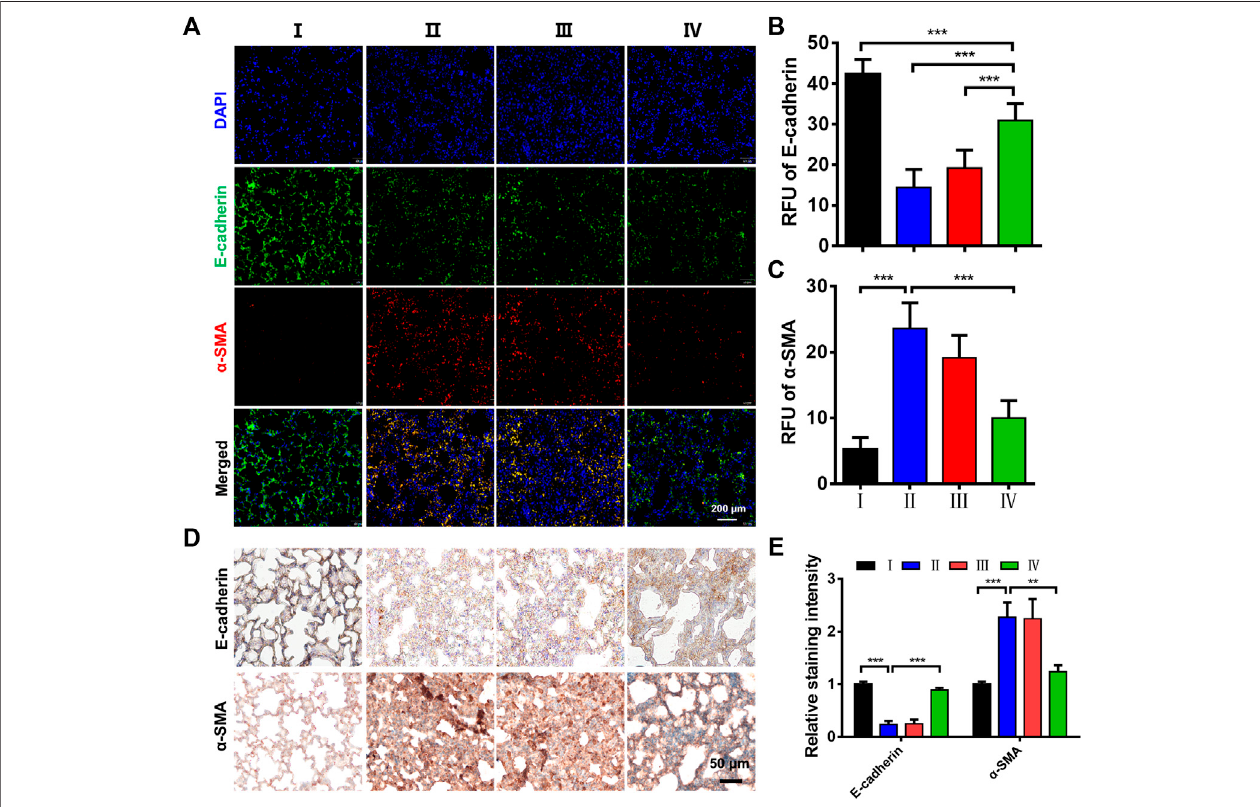
FIGURE6| EffectsofZPM@PDE-siZEB1/2ontheexpressionofE-cadherinand α -SMAinmice. (A) Immuno fl uorescenceassaysexpressionofE-cadherin(green) and α -SMA protein (red), nuclei stained with DAPI nuclear dye (blue), (B,C) The relative fl uorescence unit (RFU) of E-cadherin and α -SMA, (D) Immunohistochemical analysis expression, and (E) The relative staining intensity of E-cadherin and α -SMA. (* p < 0.05, ** p < 0.01, *** p < 0.001). For each group: Ⅰ , Control; Ⅱ , LPS; Ⅲ , LPS + Naked siZEB1/2; Ⅳ , LPS +